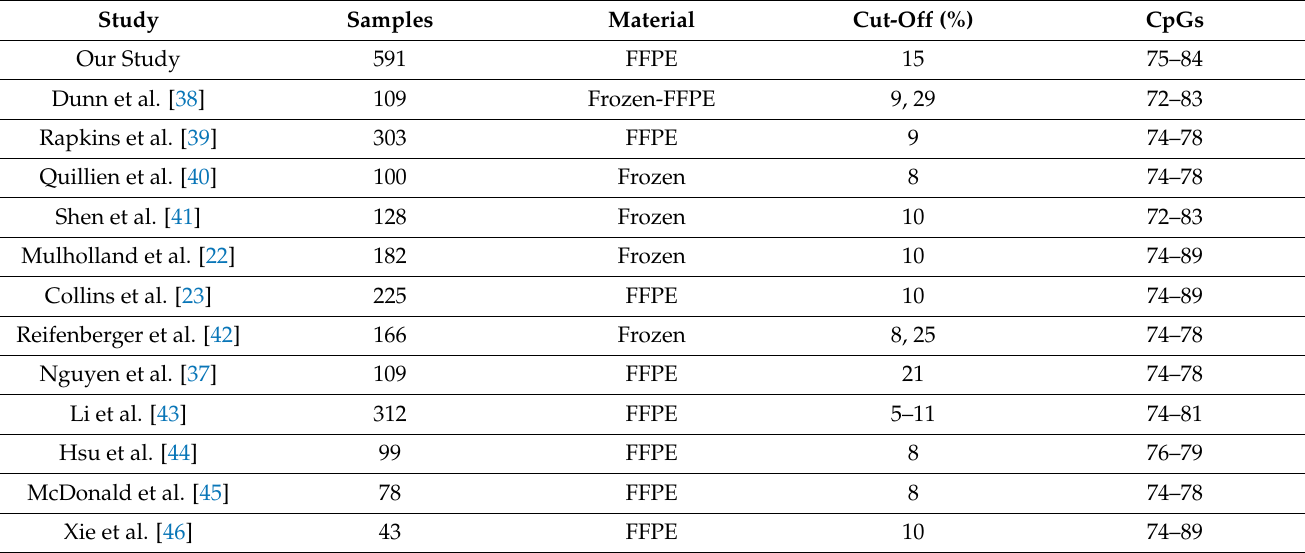
Table 2. Comparison between our study and the largest studies published in the literature re- garding methylation status of the MGMT promoter analyzed with PSQ (FFPE: formalin-fixed paraffin embedded).